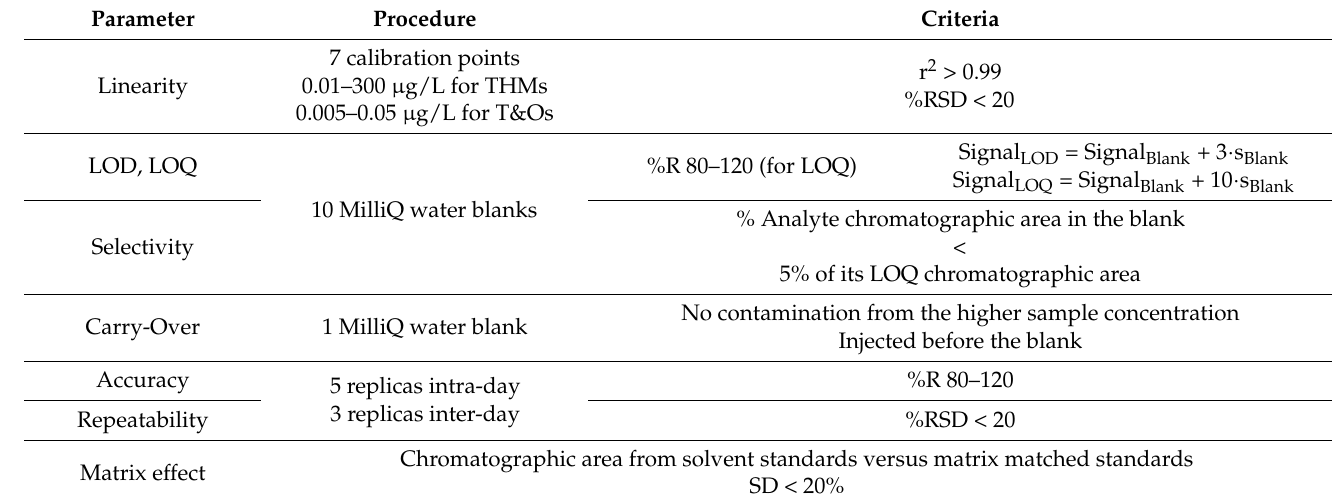
Table 1. Validation parameters studied and criteria applied following the EPA validation